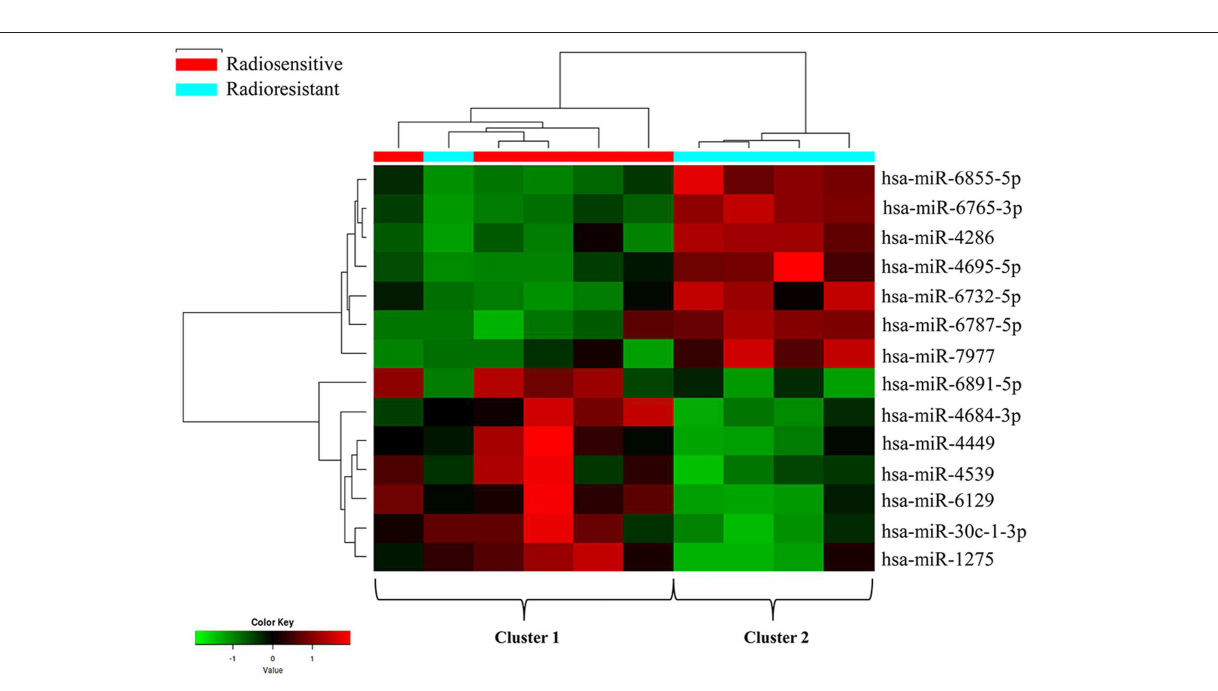
FIGURE 2 | Clustering analysis of the radioresistant and radiosensitive groups using differentially expressed miRNAs. The columns represent the cases, and the lines represent the miRNAs. Red and green indicate high and low expression levels, respectively. Cluster 1: five radiosensitive and one radioresistant; cluster 2: